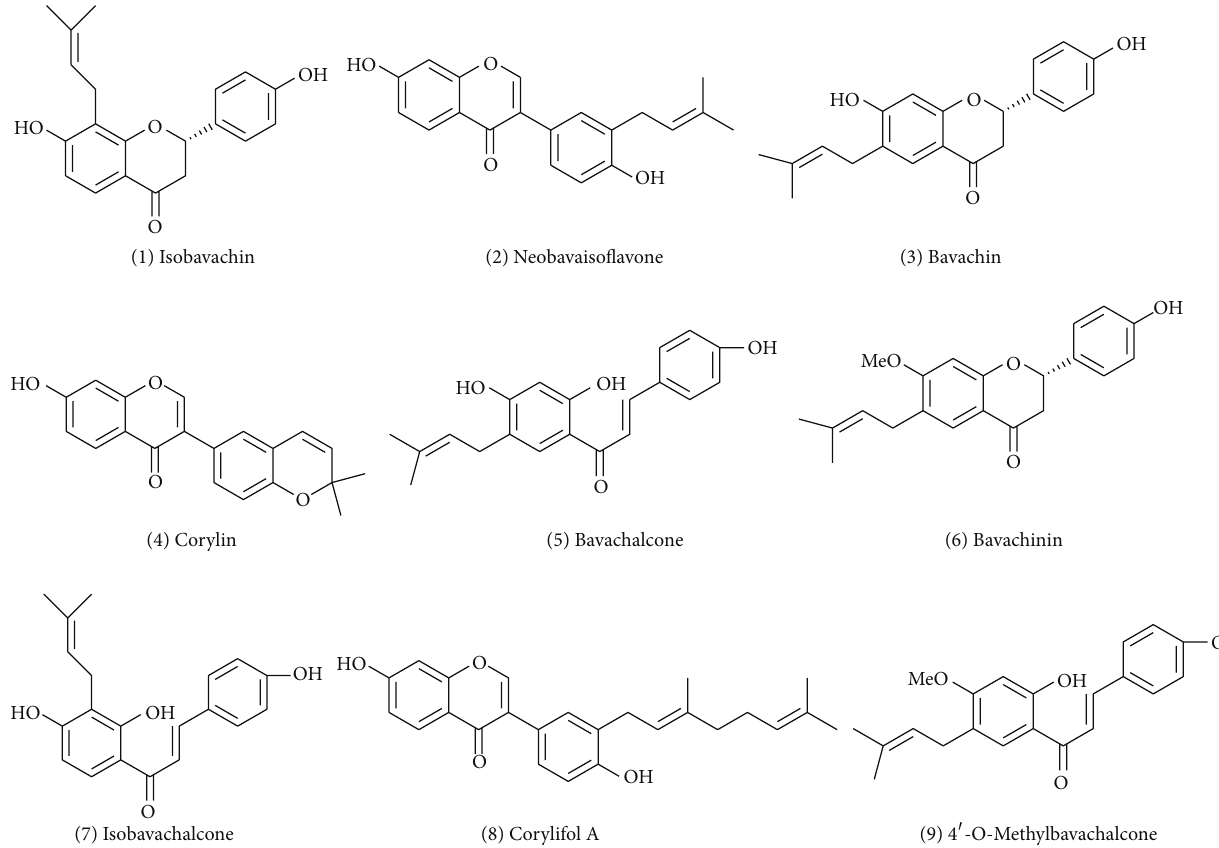
Figure 1: The chemical structures of the investigated